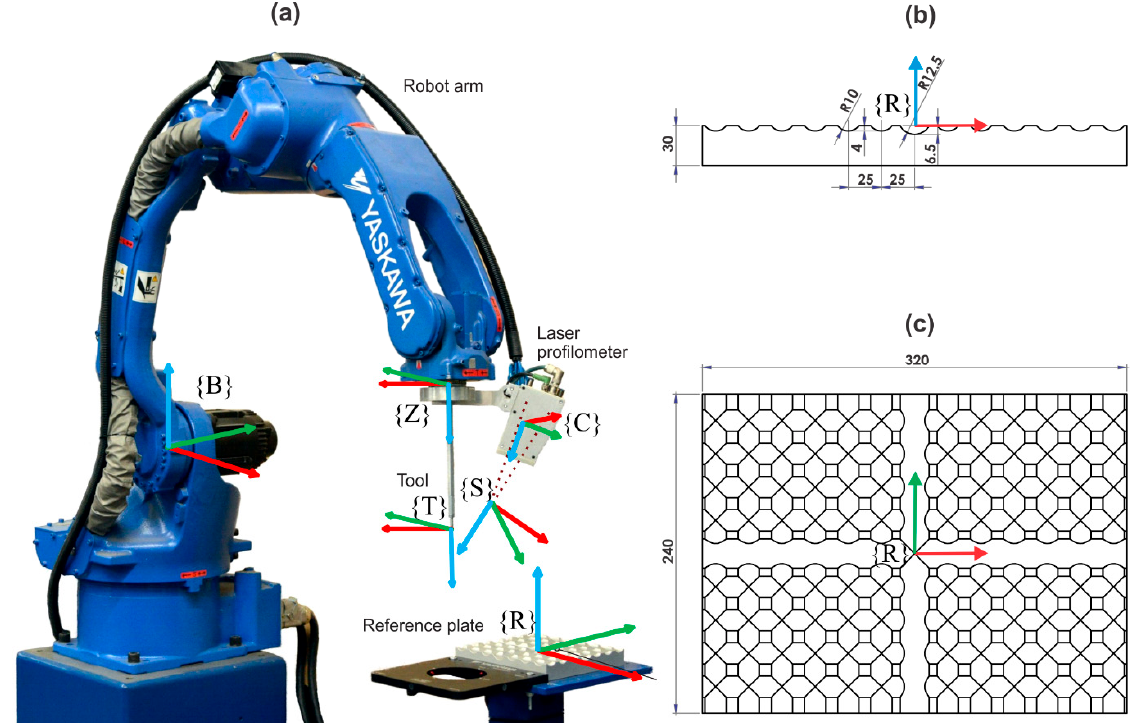
Figure 1. ( a ) The experimental system for the calibration procedure, ( b ) side view of the reference plate and ( c ) top view of the reference plate. The coordinate systems (cs) are realized by robot base cs { B }, robot zero cs { Z }, sensor cs { S }, camera cs { C }, tool cs { T }, and cs of the reference plate { R }.